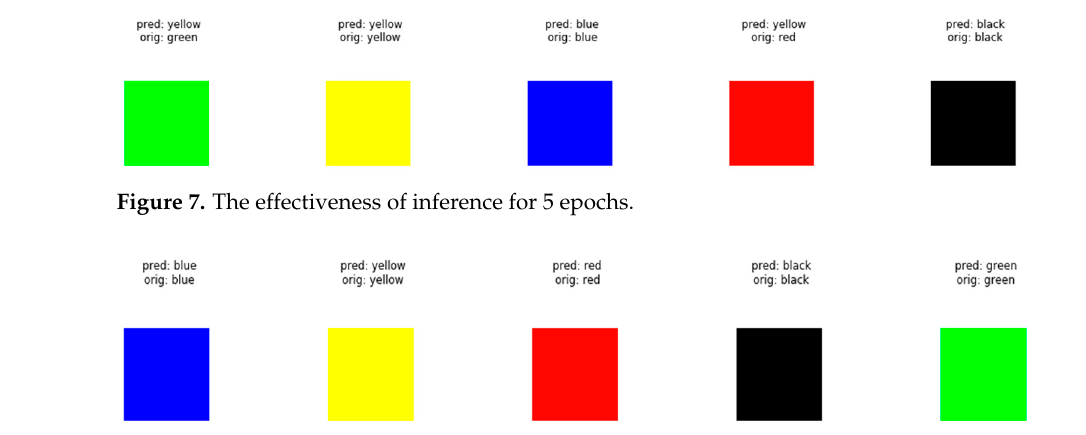
Figure 8. The effectiveness of inference for 10 epochs.